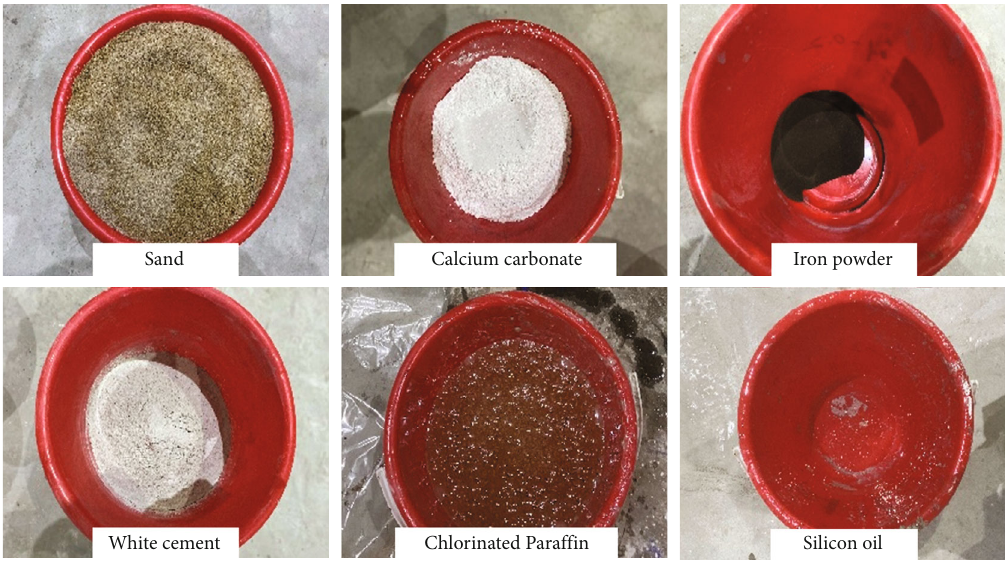
Figure 1: Basic components of similar material of surrounding rock.